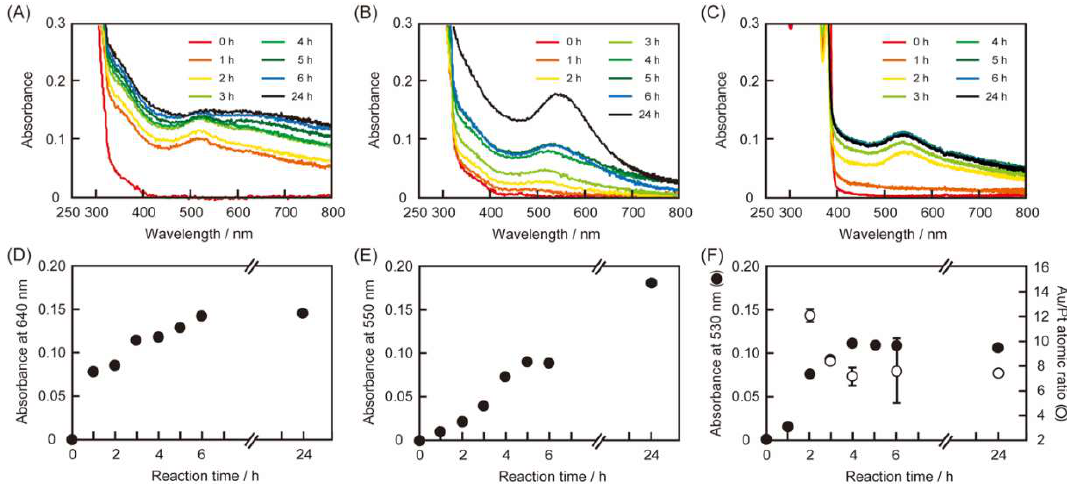
Figure 5. UV-Vis spectra of the reaction mixtures of peptides ( A , D ) RU006, ( B , E ) (NaI 2 )-RU006 and ( C , F ) (Ant 6 )-RU006 and metal ions (HAuCl 4 + H 2 PtCl 6 ) as a function of time. (Peptide) = 2.0 × 10 −4 M and (HAuCl 4 ) = (H 2 PtCl 6 ) = 5.0 × 10 −5 M in water. Each reaction was conducted at 40 °C in the dark. ( F , right axis) T-ime-dependent Au/Pt atomic ratios of the precipitates determined by EDS-SEM. (mean ± SD, n = 3).